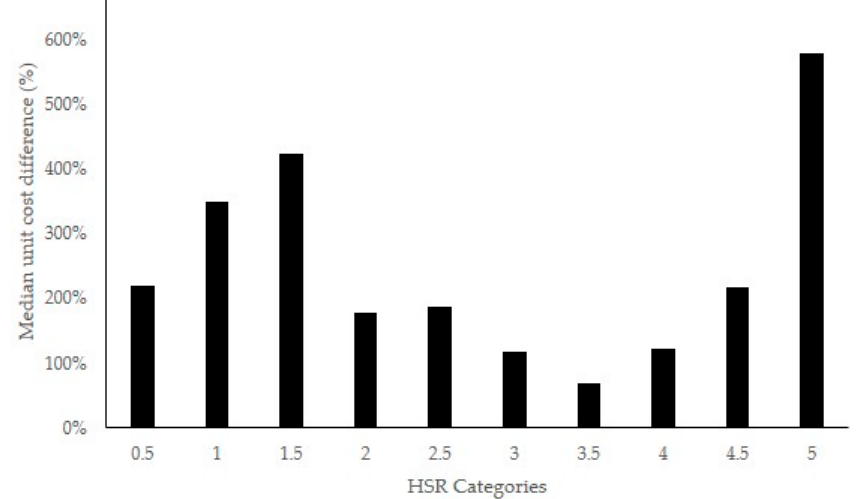
Figure 2. Median unit cost per 100 g percent di ff erence (%), per HSR category, between health food (HF) snack products sold in supermarkets and specialty HF stores compared to equivalent products sold in regular aisles (RA) of